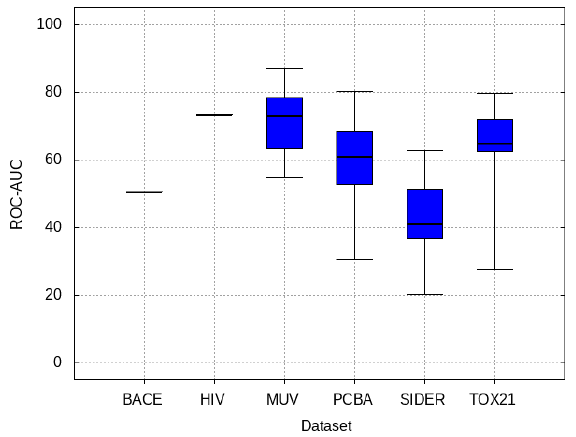
Figure 8. Performance of pre-trained models inferring on target validation set without fine-tuning. Higher ROC-AUC indicates better zero-shot inference.